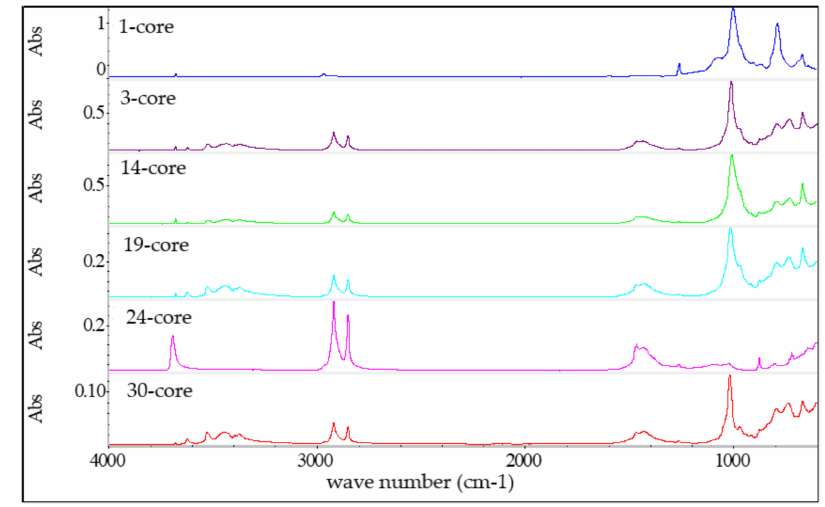
Figure 8. FTIR spectra of core insulations of tested